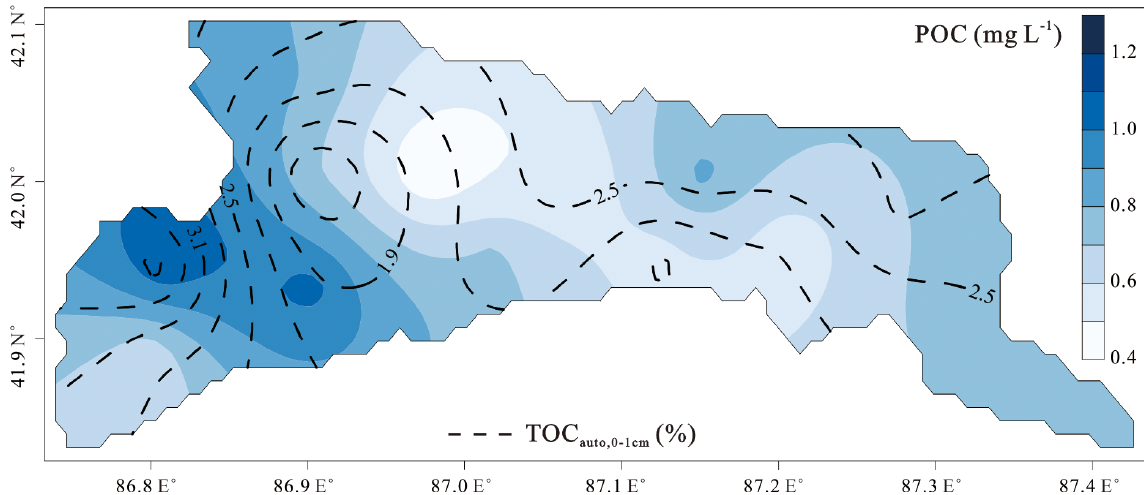
Figure 7. Spatial distributions of POC concentrations in summer (color map) and autochthonous TOC in the 0–1cm sediment (TOC auto , 0 − 1cm , dashed lines). POC data are from Wang et al.